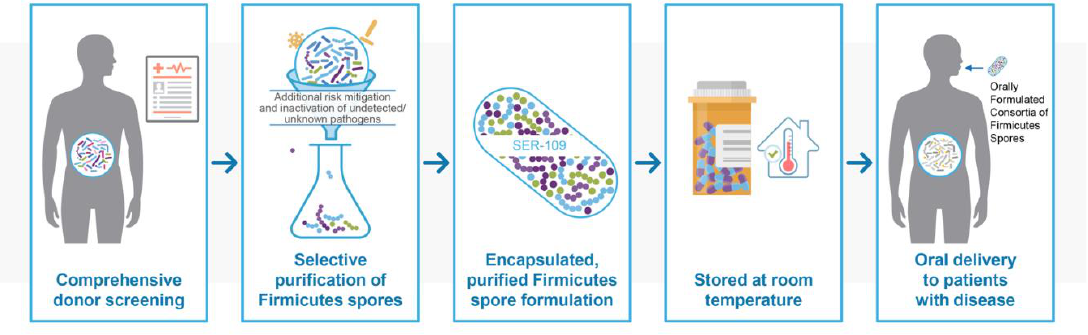
Figure 2. SER-109 Manufacturing processes mitigate risk.